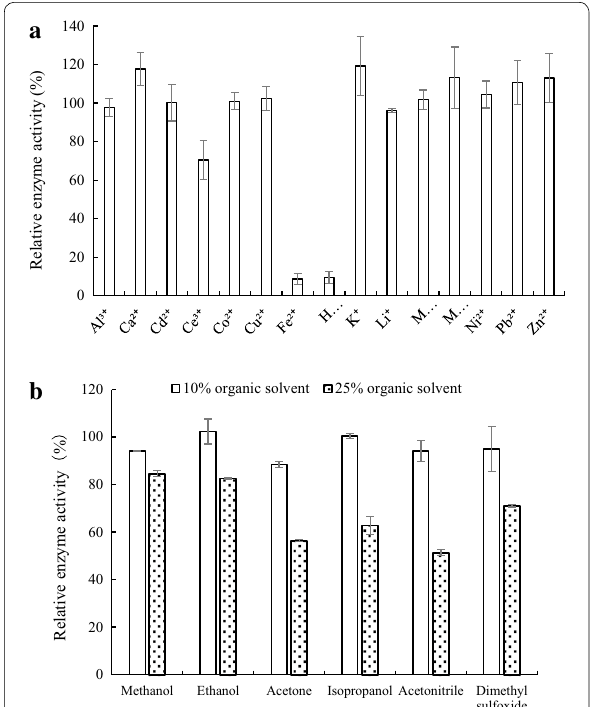
Fig. 5 Effect of metal ions a and organic solvents b on Lac2